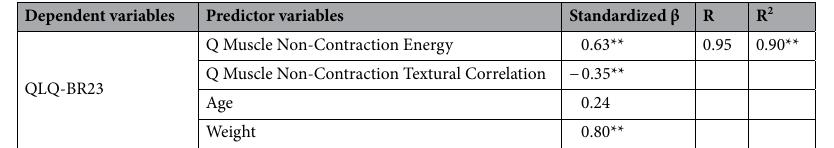
Table 4. Multiple regression analysis about the Quality of Life Questionnaire Breast Cancer (QLQ-BR23). QLQ-BR23 quality of life questionnaire breast cancer. ** P <